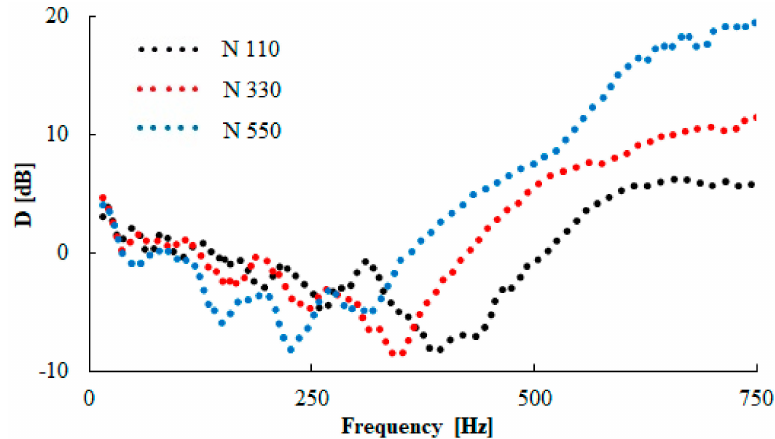
Figure 15. Frequency dependencies of the transfer damping function (D) for the tested rubber composites measuring t = 20 mm in thickness after 750,000 loading cycles, with inertial mass m = 90